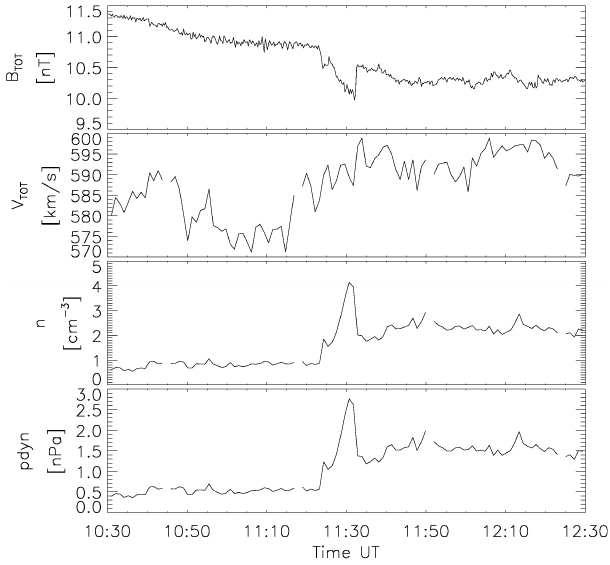
Fig. 7. Locations of the CARISMA magnetometers and the foot- print of s/c 1 in geomagnetic coordinates on 12 November